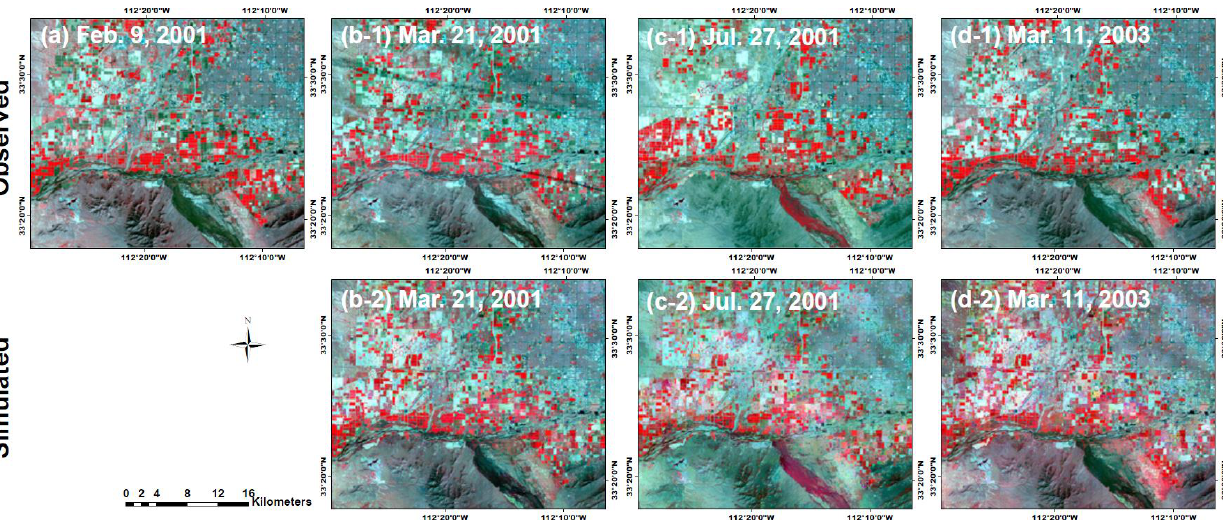
Figure 7. Visual comparison between the observed and simulated Landsat reflectance (Near-infrared (NIR)-red-green composite) using the base Landsat-MODIS pair data